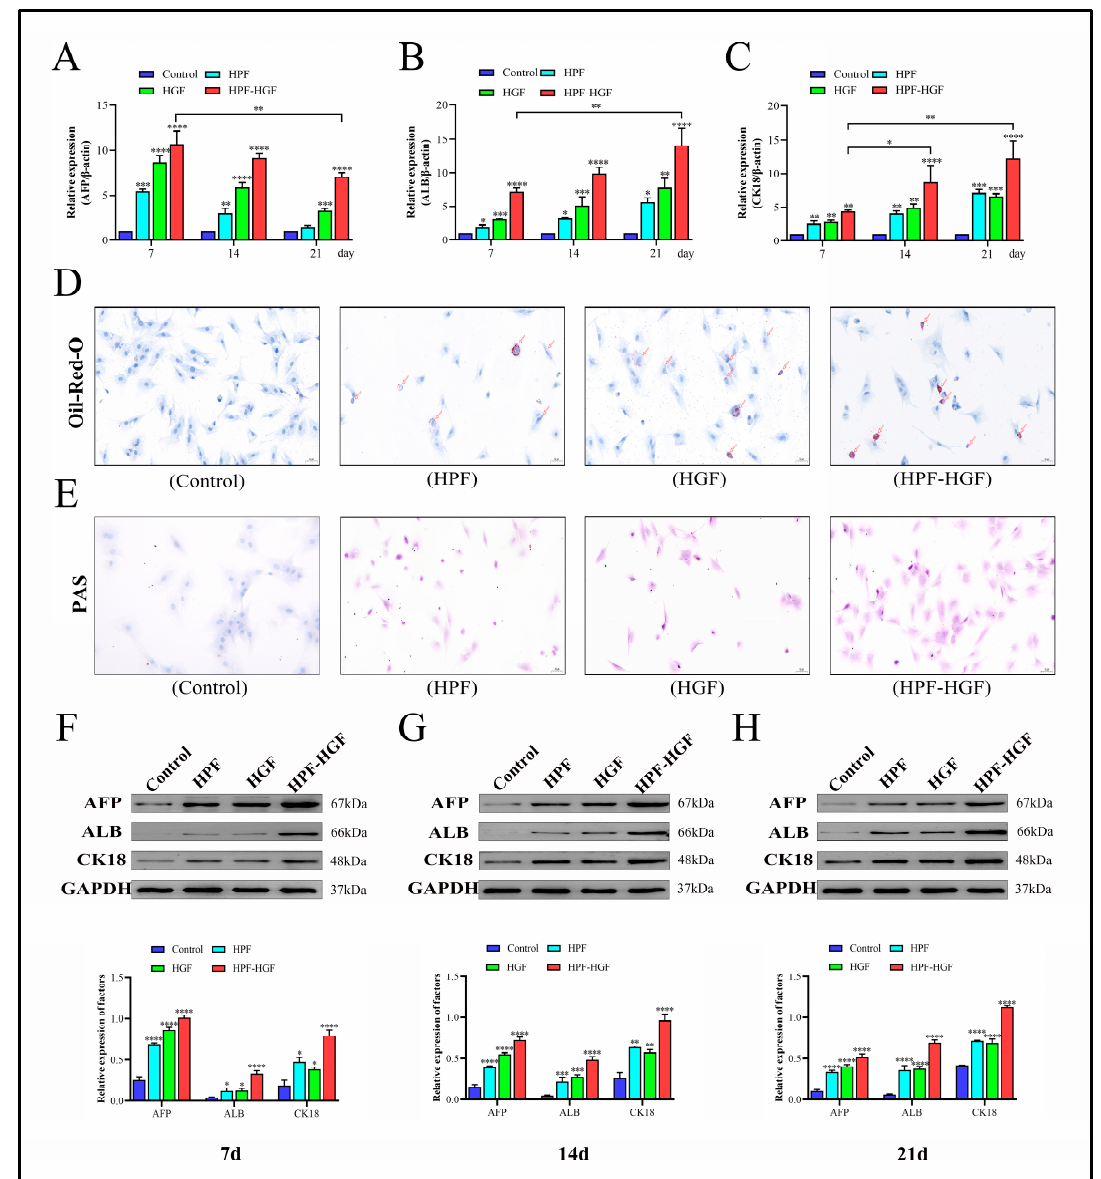
Figure 4. Inducing BMSCs to differentiate into HLCs. ( A ) RT-qPCR was used to detect the expression of AFP in HPF-, HGF- and HPF–HGF-treated BMSCs and untreated BMSCs, at different time points. ( B ) RT-qPCR was used to detect the expression of ALB in HPF-, HGF- and HPF–HGF-treated BMSCs and untreated BMSCs at different time points. ( C ) RT-qPCR was used to detect the expression of CK18 in HPF-, HGF- and HPF–HGF-treated BMSCs and untreated BMSCs at different time points. ( D ) Representative images of BMSCs stained with Oil-Red-O show the ability of BMSCs to store lipids at 21 days of differentiation (200 × magnification). ( E ) Representative images of BMSCs stained with PAS show the ability of BMSCs to store glycogen at 21 days of differentiation (200 × magnification). ( F ) Expression of the hepatocyte markers AFP, ALB and CK18 in BMSCs treated with HPF, HGF and HPF–HGF for 7 days, as well as in untreated BMSCs, was detected by Western blot. ( G ) Expression of the hepatocyte markers AFP, ALB and CK18 in BMSCs treated with HPF, HGF and HPF–HGF for 14 days, as well as in untreated BMSCs, was detected by Western blot. ( H ) Expression of hepatocyte markers AFP, ALB and CK18 in BMSCs treated with HPF, HGF and HPF–HGF for 21 days, as well as untreated BMSCs, was detected by Western blot. * p < 0.05, ** p < 0.01, *** p < 0.001 and **** p < 0.0001 compared with the control